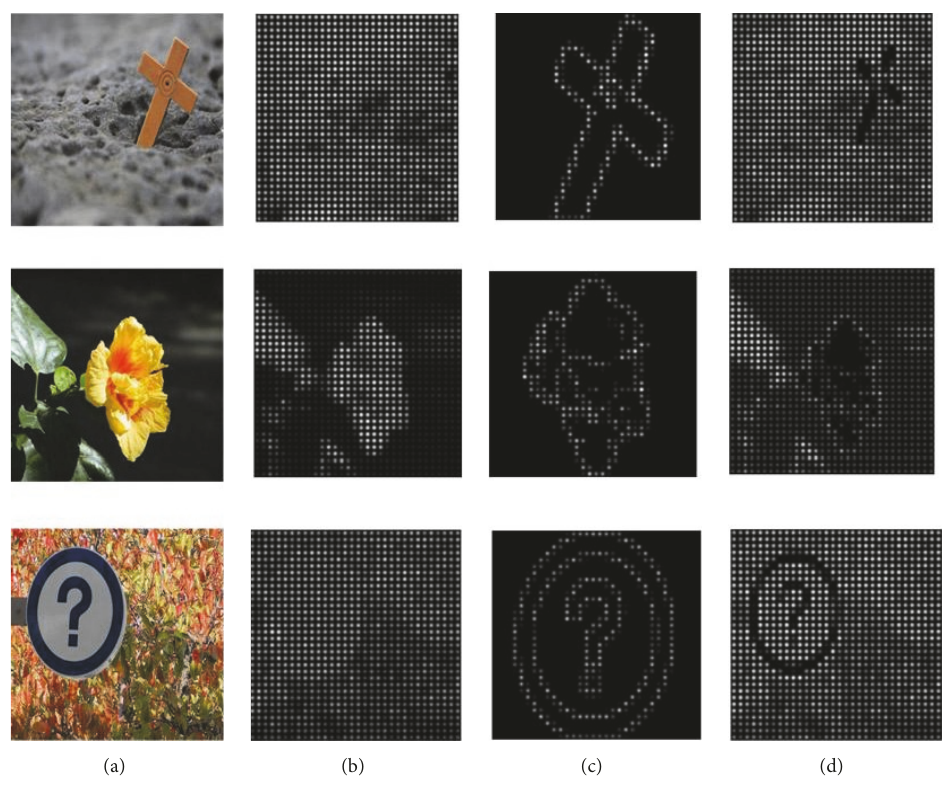
Figure 5: Results under different strategies after LRG: (a) original image, (b) image processed after LRG without optimization, (c) image processed after LRG under the strategy FZE, and (d) image processed after LRG under the strategy